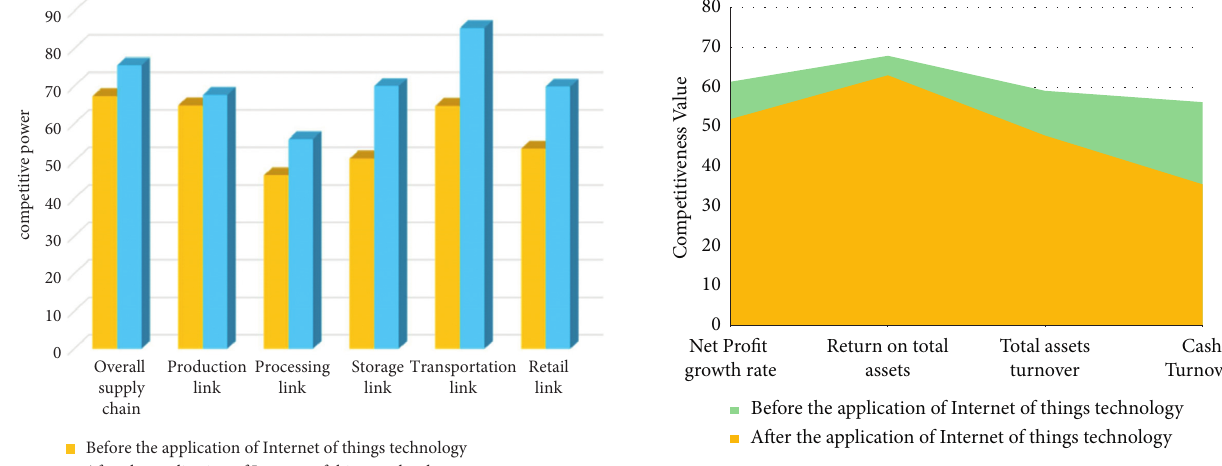
Figure 7: Supply chain competitiveness value of each subindicator of financial